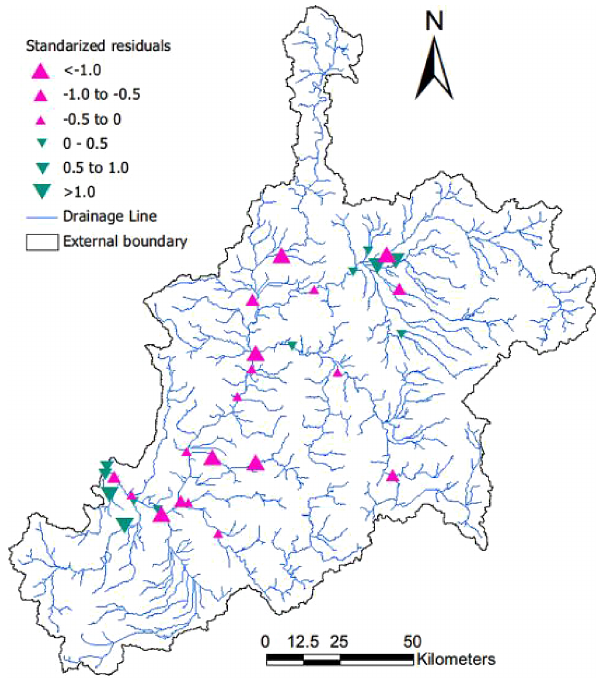
Figure 7. Model residuals for 31 monitoring stations used to cali- brate the final Ishikari SPARROW